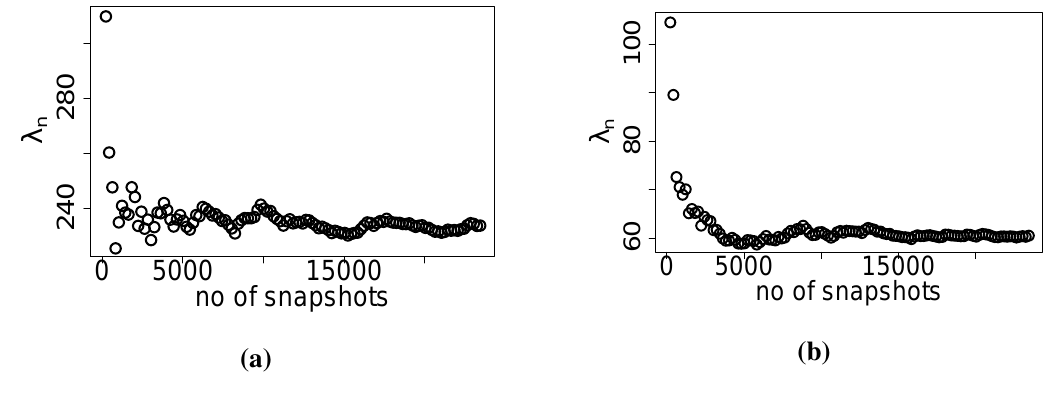
Figure B1. Eigenvalue versus the number of snapshots used for its estimation. ( a ) First eigenvalue ( n = 1); ( b ) second eigenvalue ( n = 2).